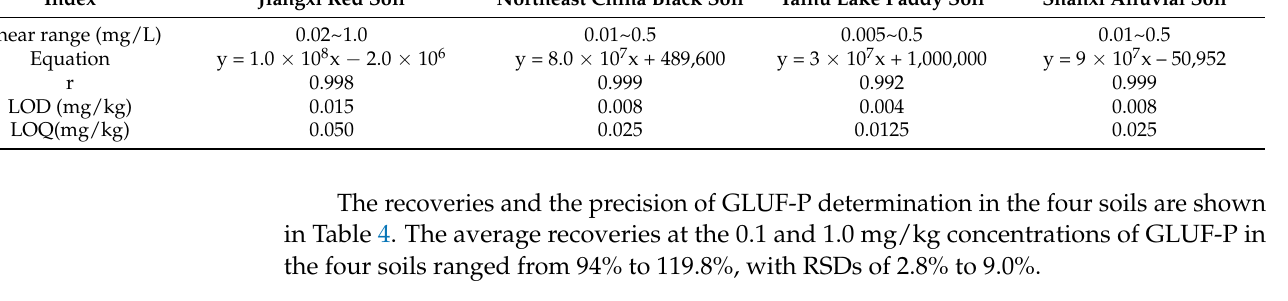
Table 4. Recovery (%) and RSD (%) data of GLUF-P (n =